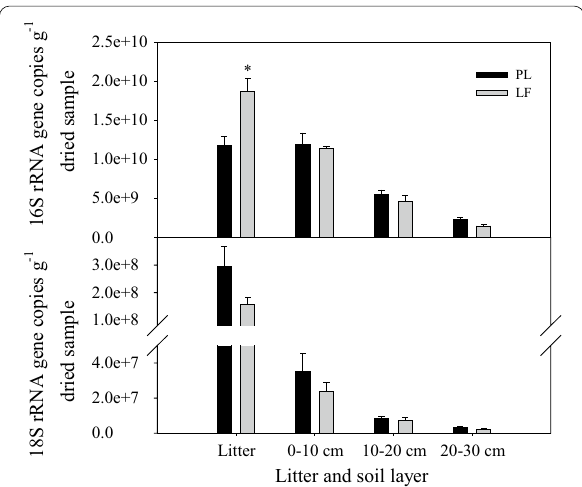
Fig. 2 Abundance of soil bacteria and fungi based on a quantitative PCR analysis comparing the monoculture Larix gmelinii plantation (PL) and mixed L. gmelinii – Fraxinus mandshurica plantation (LF). Values are presented as means SE ( n 3). *Denotes significant differences ± = between the monoculture and mixed plantations at the P < 0.05